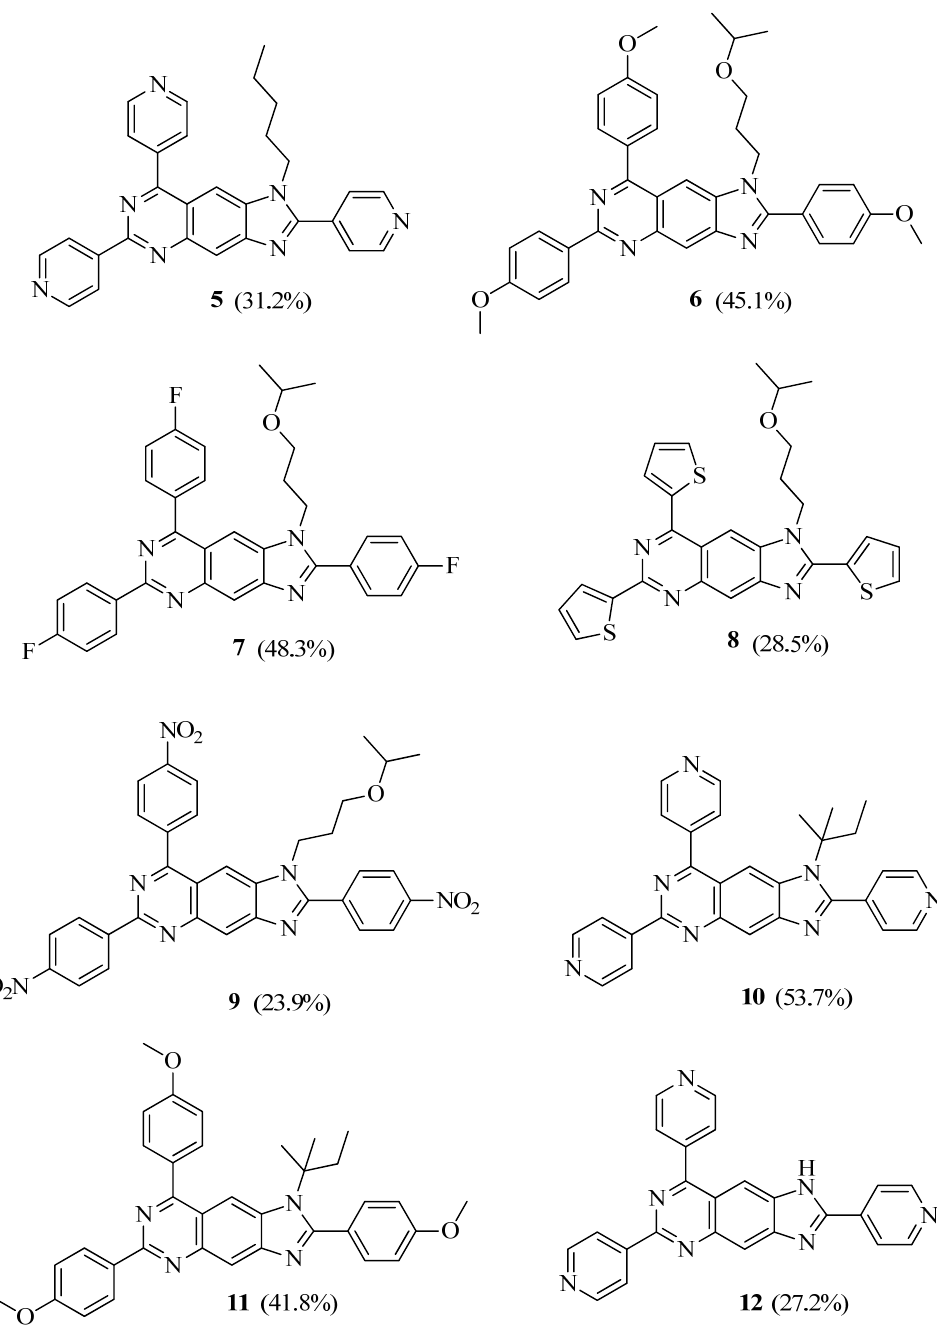
Figure 2. Chemical structures of compounds 5 – 12